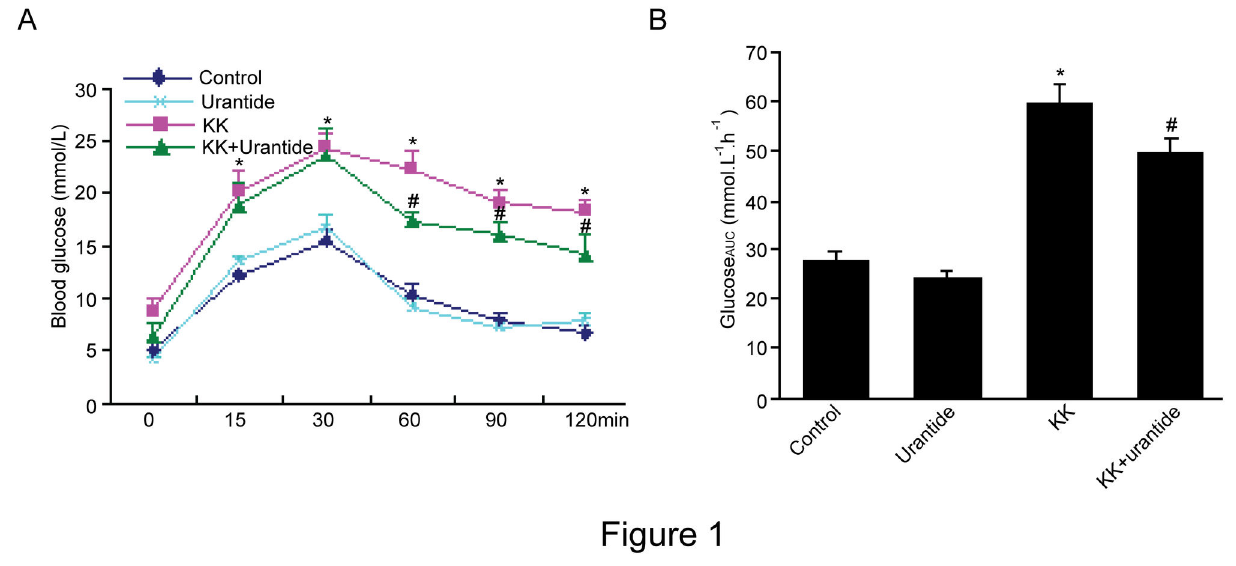
Figure 1. Effect of urantide on blood glucose levels and area under the curve (AUC) in the glucose tolerance test. KK mice were administrated urantide (30 µg/kg/day) for 14 days prior to calculation of glucose loading (A) and area under the curve (AUC) of changes in blood glucose levels (B). Control: C57BL/6J mice were treated with saline for 14 days; Urantide: C57BL/6J mice were treated with urantide for 14 days; KK:KK mice were treated with saline for 14 days; KK+Urantide: KK mice were treated with urantide for 14 days. Each value is mean±SD (n=6-8 for each group, * P <0.05 vs control; # P <0.05 vs KK group). doi: